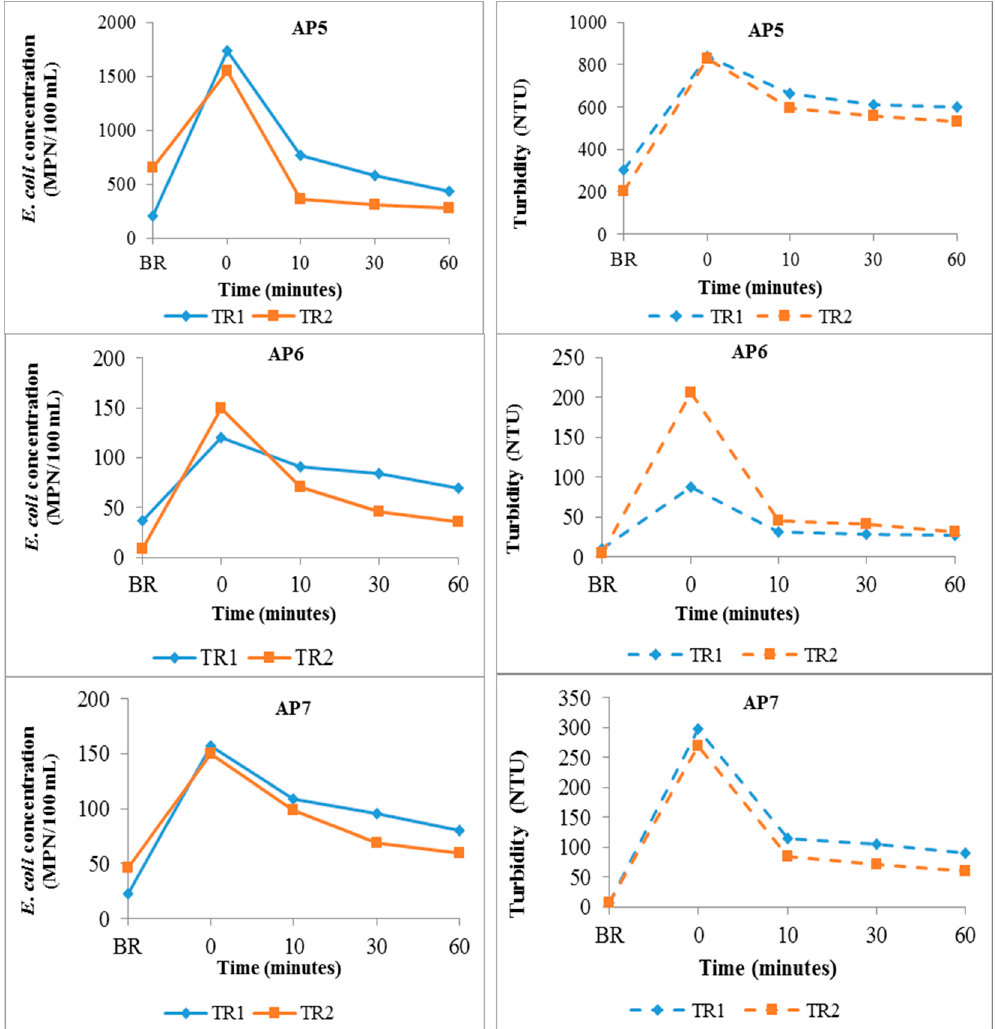
Figure 4. E. coli (solid lines) and turbidity (dashed lines) results in the water column for the sediment disturbance experiment through increased flow in the laboratory for the two experimental rounds (TR1–TR2).